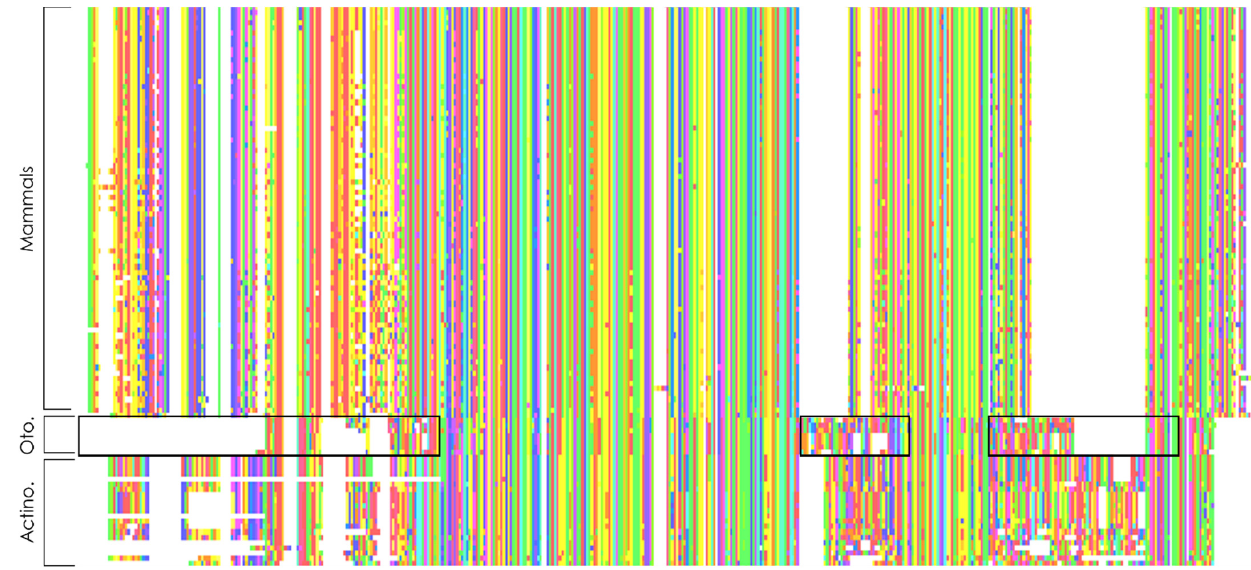
Figure 5. Overview of CCNO multiple sequence alignment. Framed areas show parts of the alignment with the most divergence in Otomorpha fish when compared to other species. Oto.: Otomorpha; Actino.: Actinopterygii.